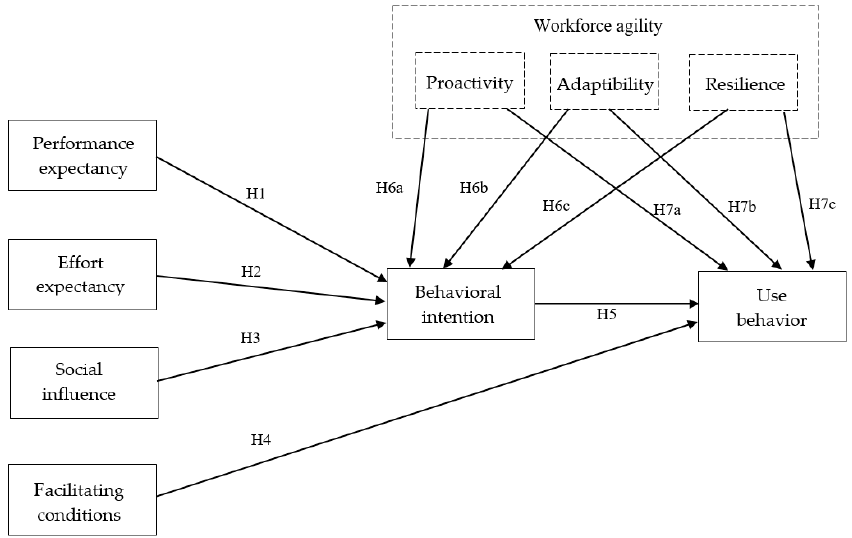
Figure 1. EISSMM research